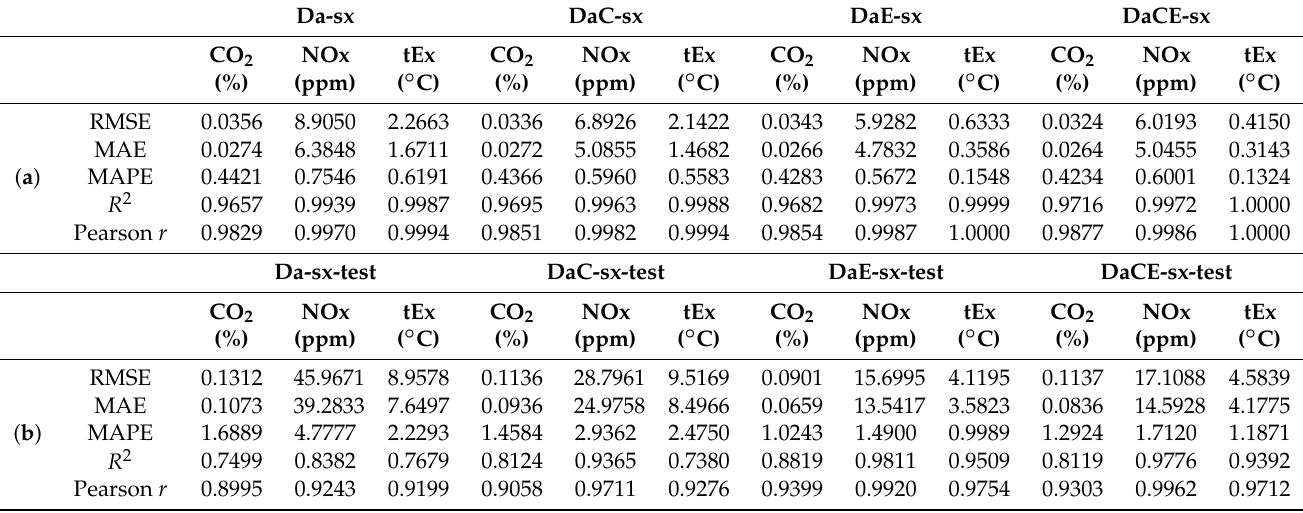
Table 9. Metrics from different datasets for the SVM model with the no-SCR mode: ( a ) training from the ATC training set and metrics from the validation set; ( b ) trained model tested from the BTC and its